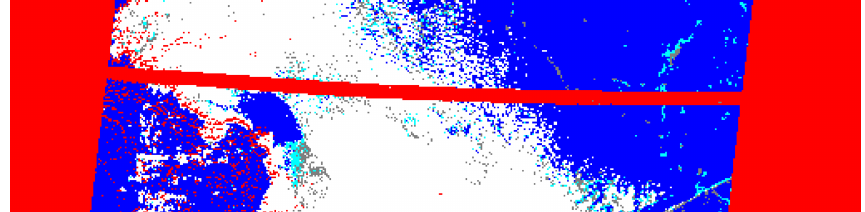
Figure 3. Map of the MISR RCCM product for Path 168, Orbit 68283, Block 110 and camera CA. All RCCM products are generated at the spatial resolution of 1100m and provided as arrays of 512 pixels by 128 pixels. The total size of the Block area is 563.2km across- track by 140.8km along-track, while the parallelogram-shaped ground area inside the Block is about 380km across-track. Color coding: red, no retrieval (RCCM=0) or fill value (RCCM=255); white, cloud with high confidence (RCCM=1); gray, cloud with low confidence (RCCM=2); aqua, clear with low confidence (RCCM=3); and blue, clear with high confidence